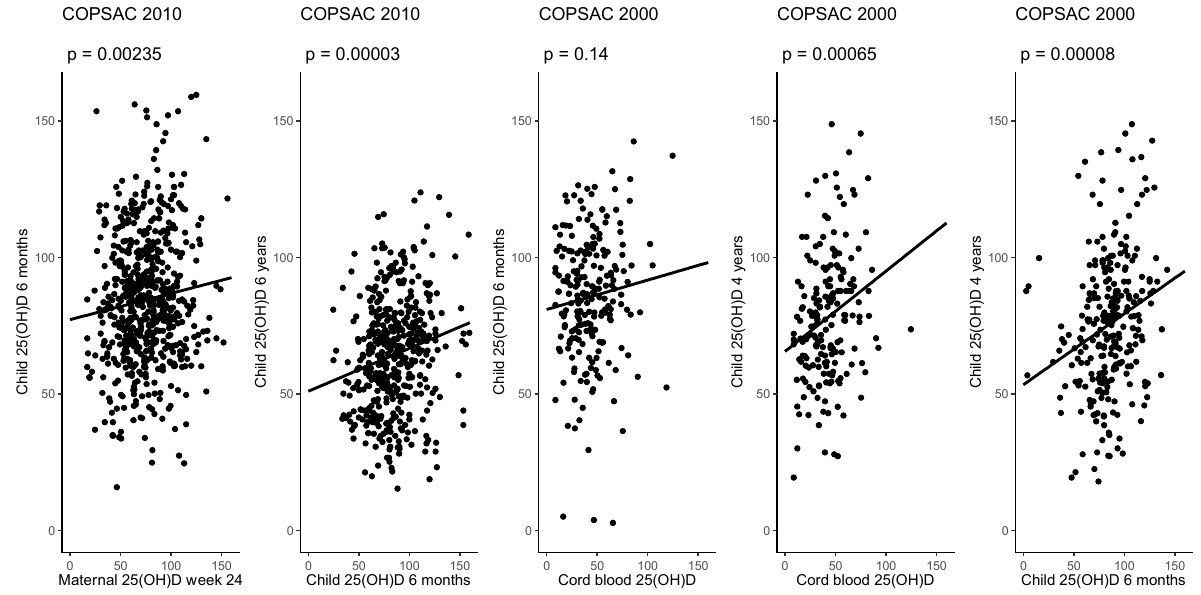
Figure 1. The associations between 25(OH)D at pregnancy week 24, age 6 months and 6 years in COPSAC 2010 and cord blood, age 6 months and 4 years in childhood in COPSAC 2000 . All values are in nmol/L.